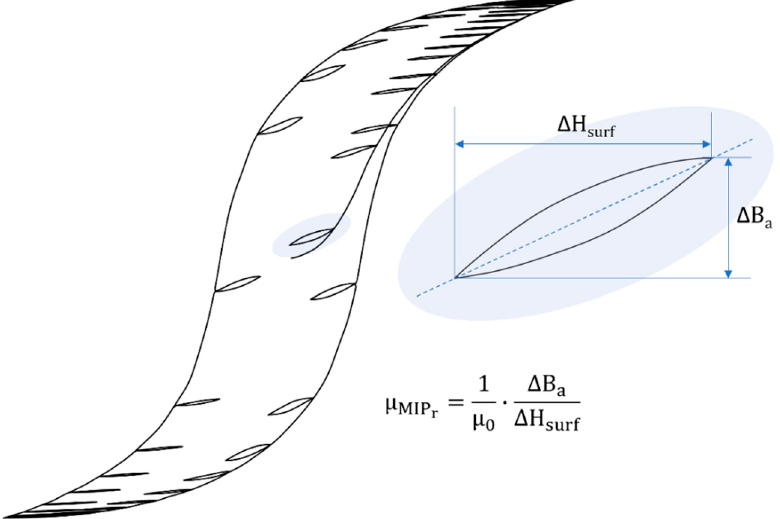
Figure 8. MIP illustration and equation [37].